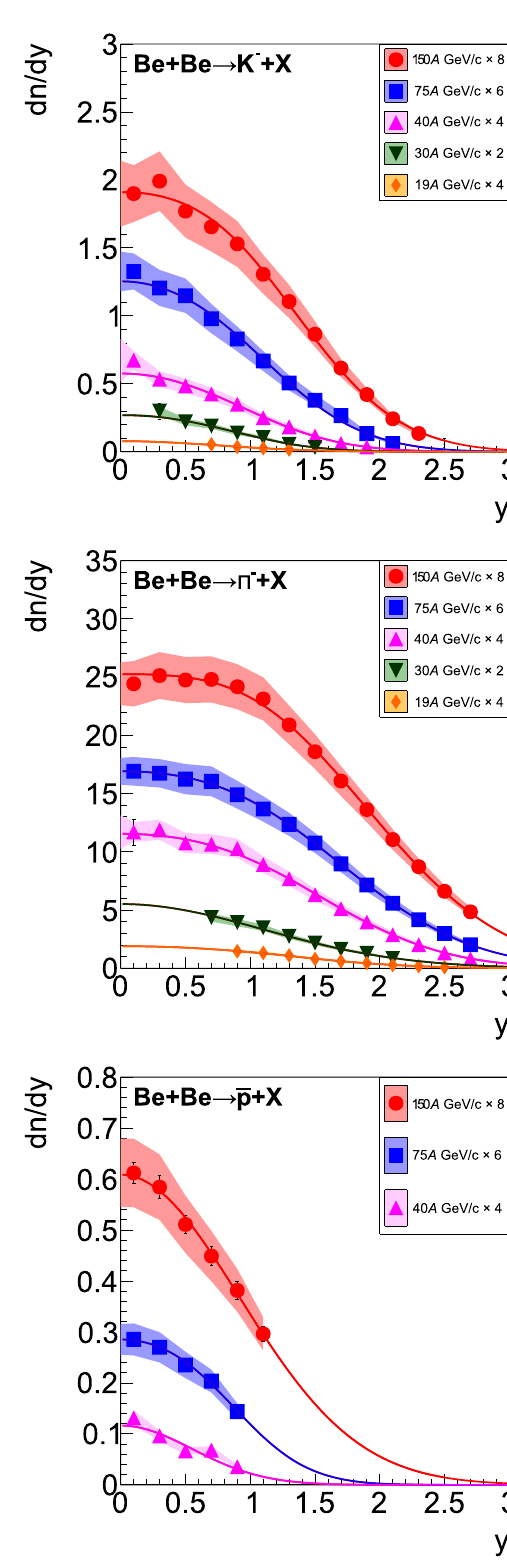
ferent beam momenta were scaled by the following factors for better visibility: 150 A GeV / c by factor 8, 75 A GeV / c by factor 6, 40 A GeV / c by factor 4, 30 A GeV / c by factor 2 and 19 A GeV / c by factor